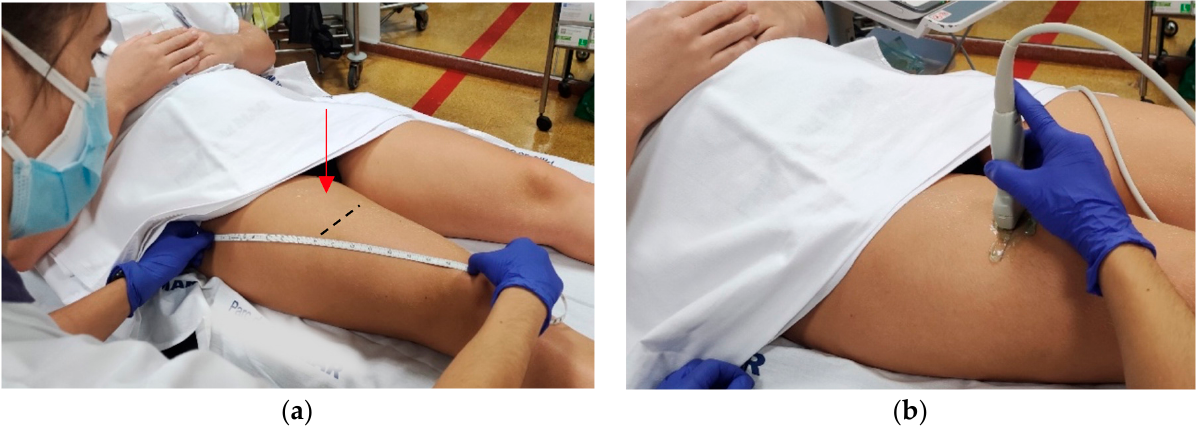
Figure 2. Measuring points of thickness and cross-sectional area of the rectus femoris muscle ac- cording to the SARCopenia through UltraSound (SARCUS) protocol [20,21]. ( a ) MT and CSA of RF were measured at the dominant thigh at 50% (red arrow) of the distance between the greater tro- chanter and the proximal edge of the patella, with the patient’s legs in neutral position. The black line indicates where the images should be captured.; ( b ) A 5 cm width, 12 MHz linear transducer was placed perpendicular to the muscle. Abbreviations: CSA: Cross-sectional area, MT: muscle thickness, RF: Rectus femoris muscle.